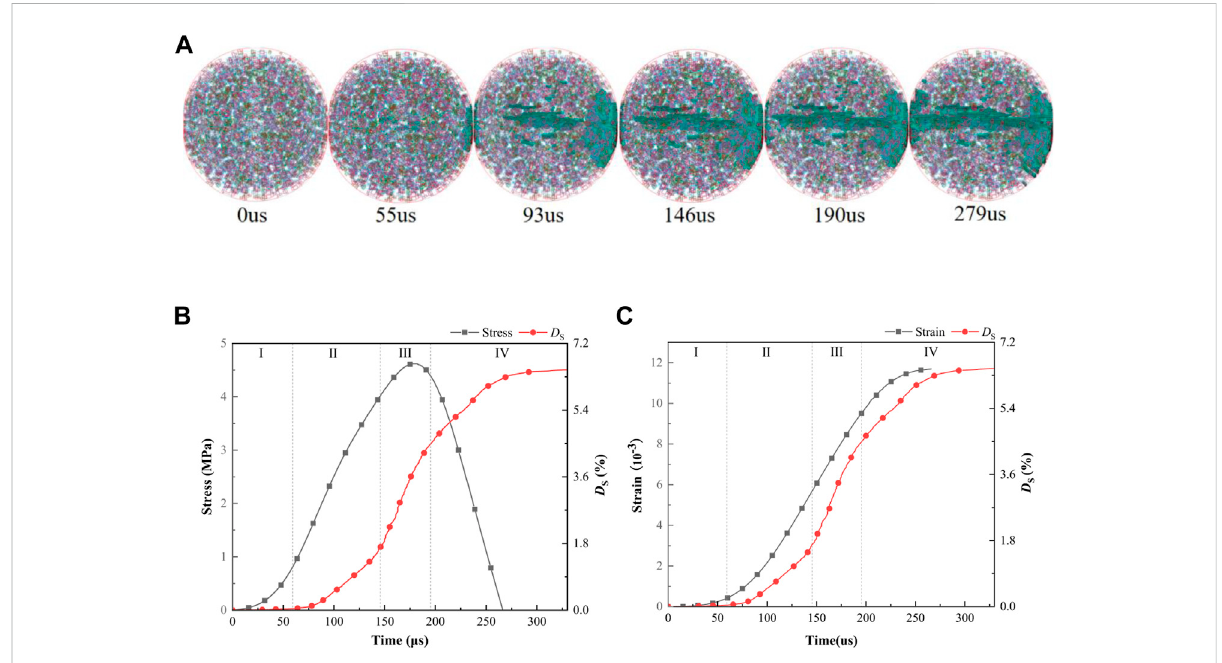
FIGURE 9 Crackextractionandvariationtrendofdamagedegreeof45.1 s − 1 . (A) Extractedcrackofthemodel, (B) Stressanddamagedegree, (C) Strainand damage